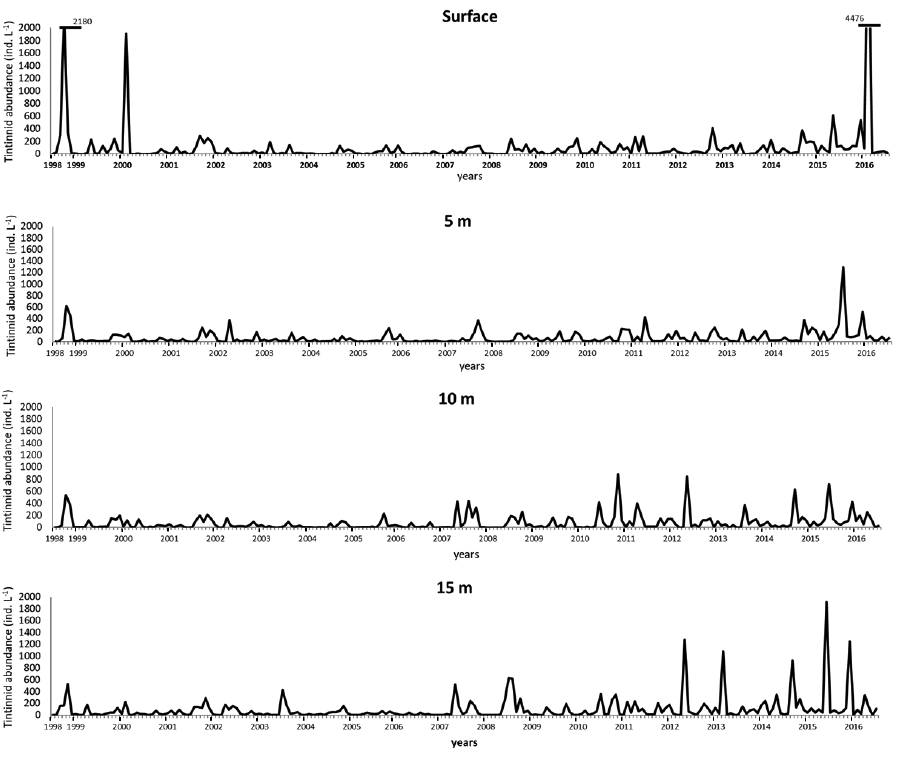
Figure 5. Long-term fluctuations of total tintinnid abundance (ind. L -1 ) at different depths (surface, 5 m, 10 m and 15 m) from July 1998 to July 2016 in the Gulf of